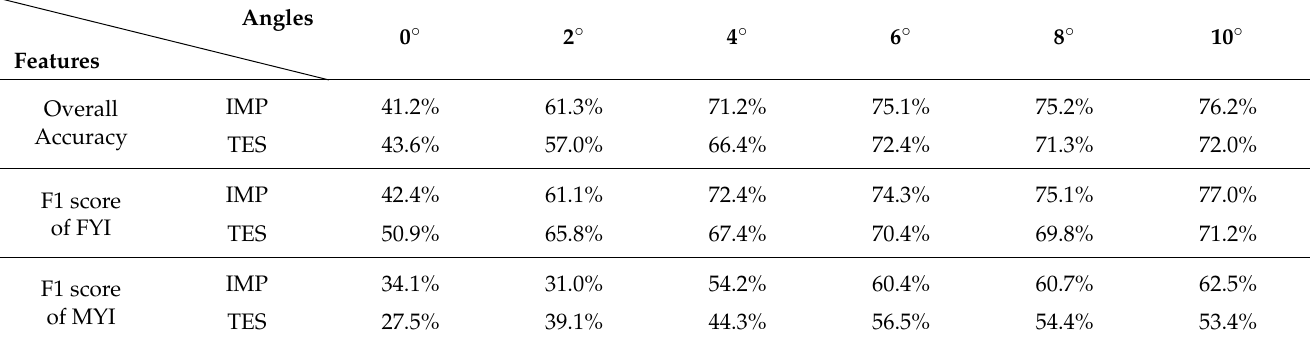
Table 10. Overall accuracies and F1 scores of IMP and TES at small incidence angles.